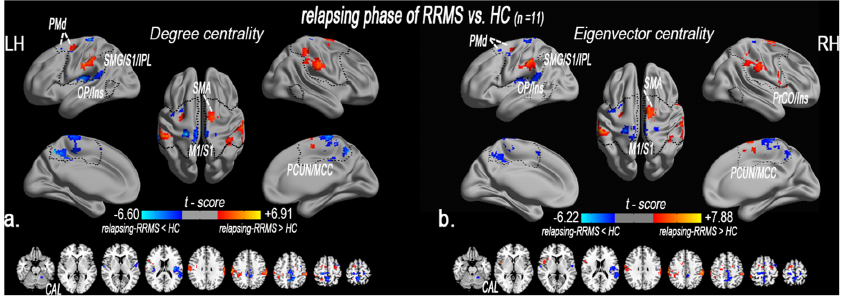
Fig 2. Altered centrality of the sensory-motor network in the relapsing phase of RRMS patients. The spatial distribution of abnormal DC (a) and EC (b) in the relapsing patients compared with the HCs (paired t - test, n = 11, P < 0.05, AlphaSim corrected critical cluster size k = 20). Spatial distribution was visualized using surface brain imaging in Brainnet Viewer (www.nitrc.org/projects/bnv/). Note : DC = degree centrality; EC = eigenvector centrality; fO = frontal operculum; IPL = inferior parietal lobule; k/k 0 = normalized DC; LH = left hemisphere; M1 = primary motor cortex; MNI = Montreal Neurological Institute; MCC = middle cingulate cortex; RRMS = relapsing-remitting multiple sclerosis; PMd = premotor dorsal; RH = right hemisphere; OP/Ins = operculum parietale/insula; PostG = postcentral gyrus; SPL = superior parietal lobule; SMA = supplementary motor area; u/u 0 = normalized EC; the same abbreviations are used for all the figures and tables